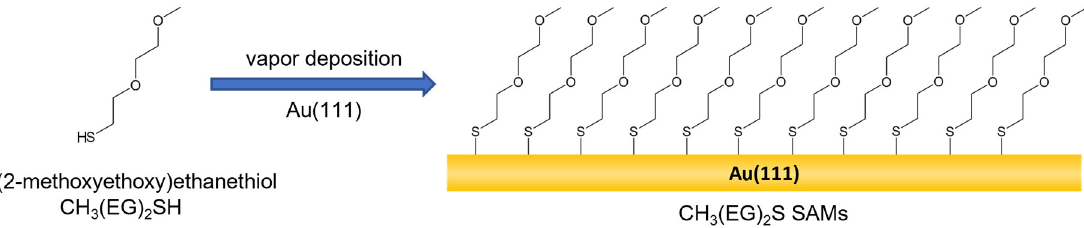
Figure 1. Chemical structure of CH 3 (EG) 2 SH and formation of CH 3 (EG) 2 S SAMs on Au(111) via vapor deposition.